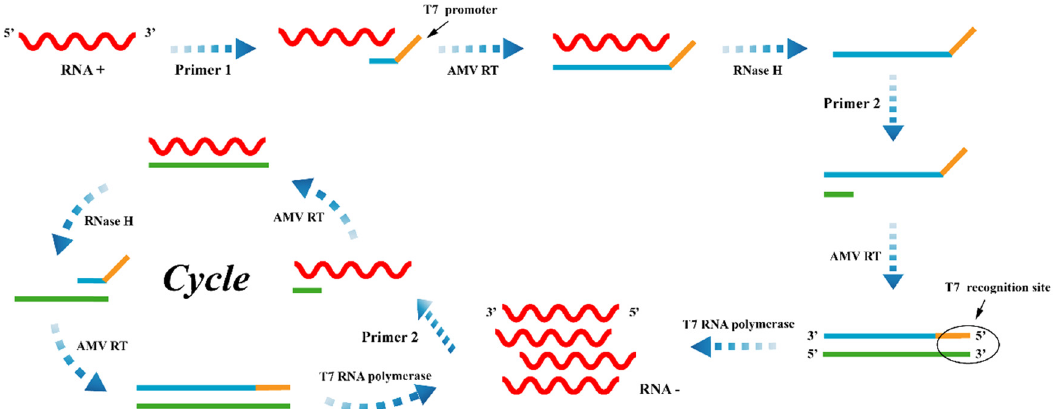
Figure 1: The schematic diagram of NASBA reaction: the designed primer 1, containing a T7 - promoter sequence, could hybridize with target RNA to initiate primer extension and form RNA – cDNA hybrid chain. RNA was hydrolyzed from the RNA – cDNA hybrid chain by RNase H and formed a single strand of cDNA. The cDNA triggered primer 2 extends and forms a double - stranded DNA intermediate. These intermediates containing T7 RNA polymerase recognition sites were used as templates for in vitro transcription ampli fi cation and generated single - stranded RNA products. The products are the complementary strand of the target RNA, so it combined with primer 2 again to enter the next ampli fi cation cycle and accumulate a large number of free RNA